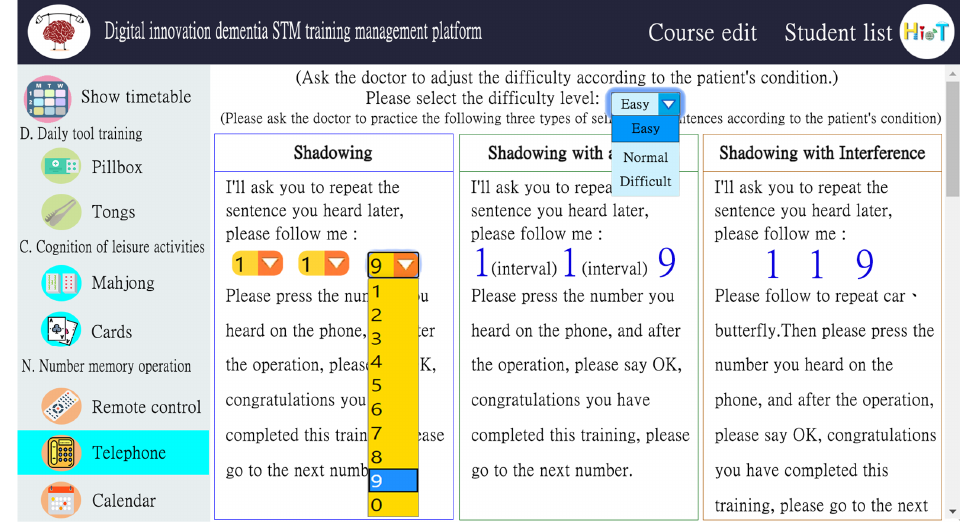
Figure 9. Digital short-term memory cognitive training content management platform.